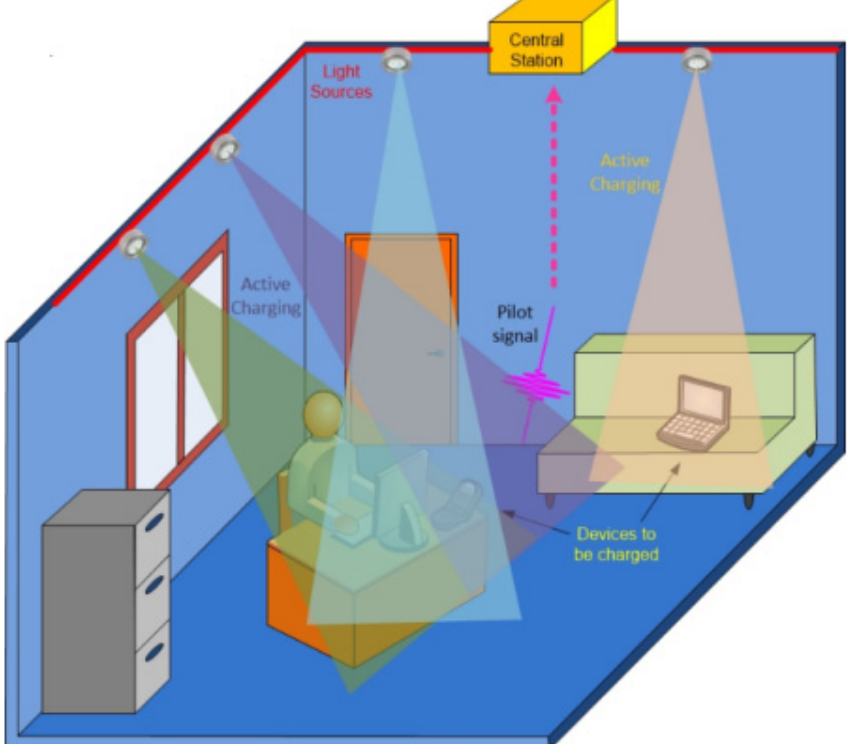
Figure 26. Diagram of the proposed wireless energy transfer system [90].